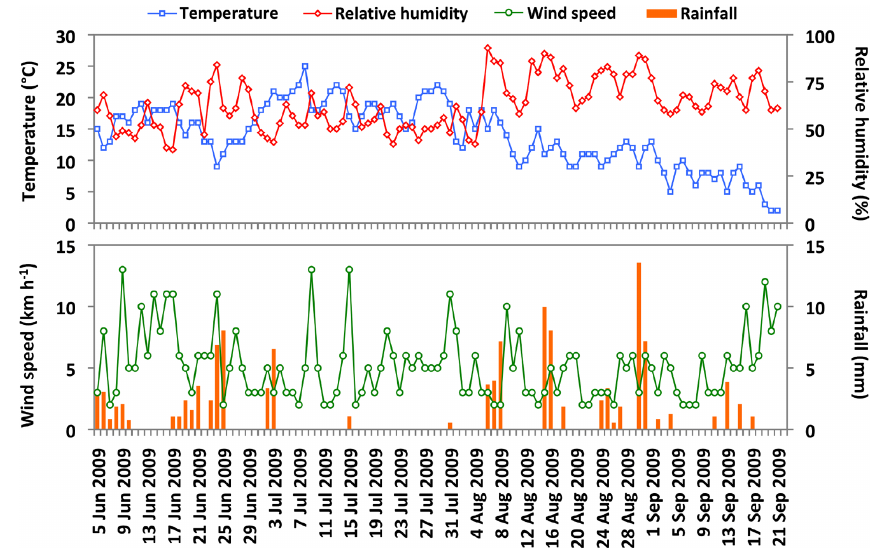
Figure 2. The daily average variations of meteorological parameters from 5 June to 21 September 2009 at the observation site in central